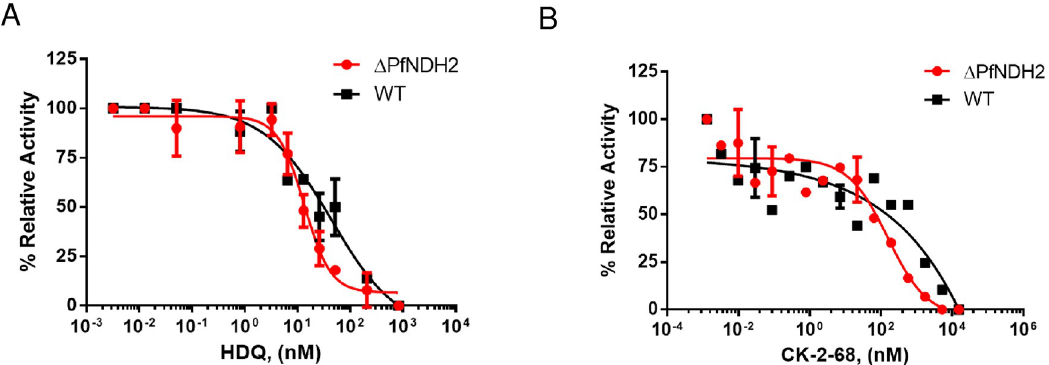
Fig 4. HDQ and CK-2-68 directly inhibit mitochondrial ubiquinol-cytochrome c reductase activity in vitro . In each measurement, the same amount of mitochondria of knockout or WT (25 μ g of sample) was used. Reduction of cytochrome c was followed spectrophotometrically at 550 nm (Materials and methods). The rates of reduction in the presence of various concentrations of inhibitors were normalized to that of no drug controls (average of 5 replicates), resulting in relative activity (%). (A) Inhibition by HDQ. Data shown is plotted from n = 3 biological replicates. (B) Inhibition by CK-2-8. Data shown is a representative of n = 2 biological replicates. Error bars indicate standard deviations of technical replicates (two or three) in the representative